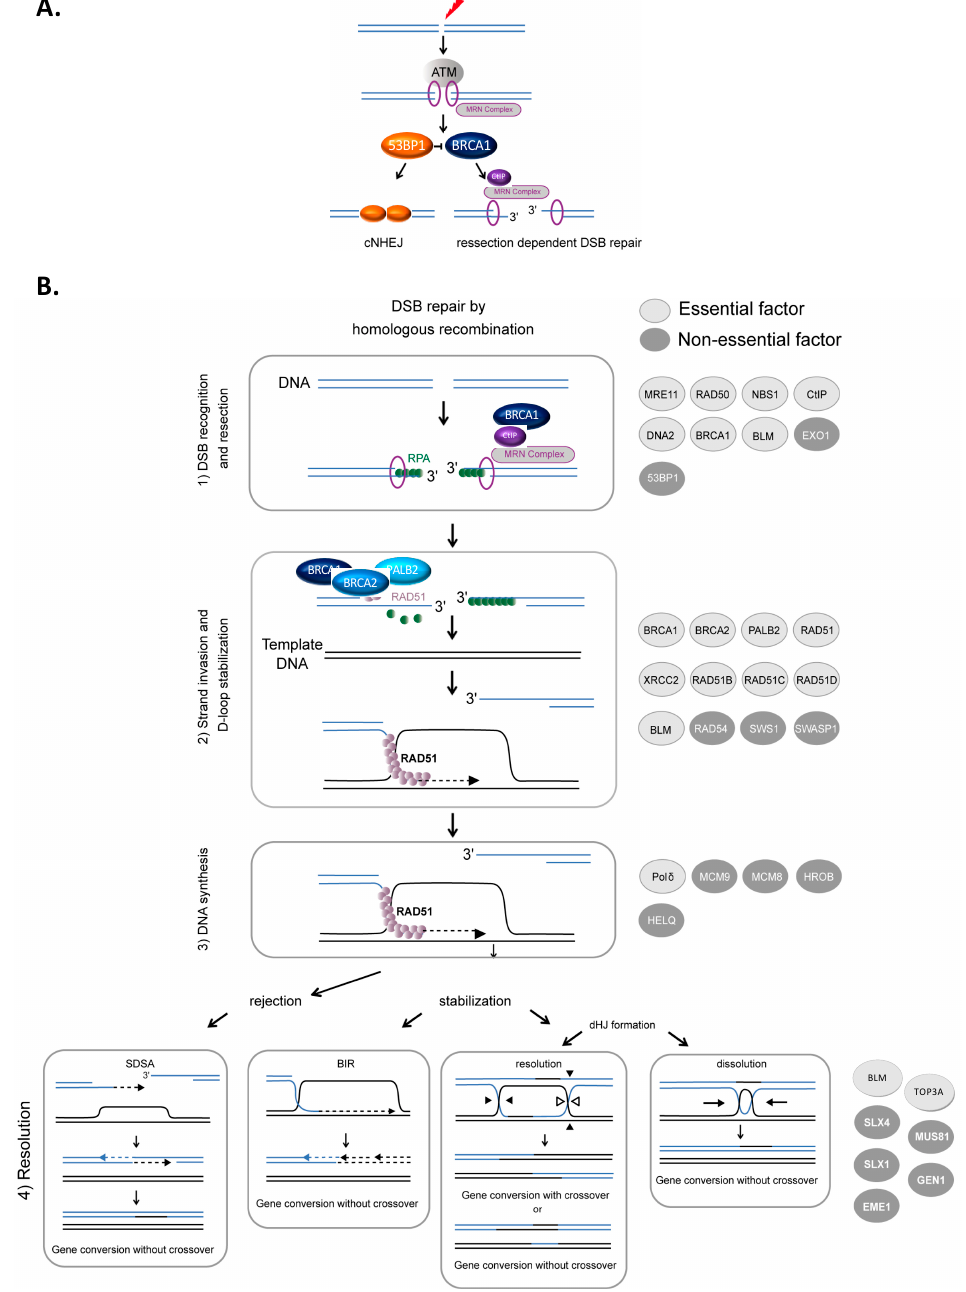
Figure 1. HR-mediated DSB repair. ( A ). Signaling and competition between cNHEJ and resection [34]. The involvement of 53BP1, BRCA1 and the MRN complex. ( B ). Model of DSB repair by HR. (1) The MRN complex initiates a 5 ′ to 3 ′ resection under the control of BRCA1/CtIP, generating a 3 ′ single-stranded DNA (ssDNA) ( A ). (2) RAD51 is then loaded to the 3 ′ single-stranded DNA by the combined action of BRCA2/PALB2 and BRCA1, resulting in the formation of an ordered RAD51-ssDNA nucleofilament. The invasion of homologous duplex DNA by the RAD51-ssDNA filament induces the formation of a displacement loop (D-loop). (3) The invading strand primes DNA synthesis. (4) The D-loop can be either dismantled, leading to DSB repair by synthesis-dependent strand annealing (SDSA) or stabilized, leading to either DSB repair by BIR or the formation of a double Holliday junction (dHJ). The dHJ can be resolved or dissolved, leading to a repair product either associated with a crossover event or not. The proteins involved in each corresponding step are listed on the right side of the figure. Light gray circles indicate essential factors; essential factors are defined as genes whose knockout leads to embryonic lethality in mice. Dark gray circles indicate nonessential factors; these are genes whose KO does not lead to embryonic lethality in